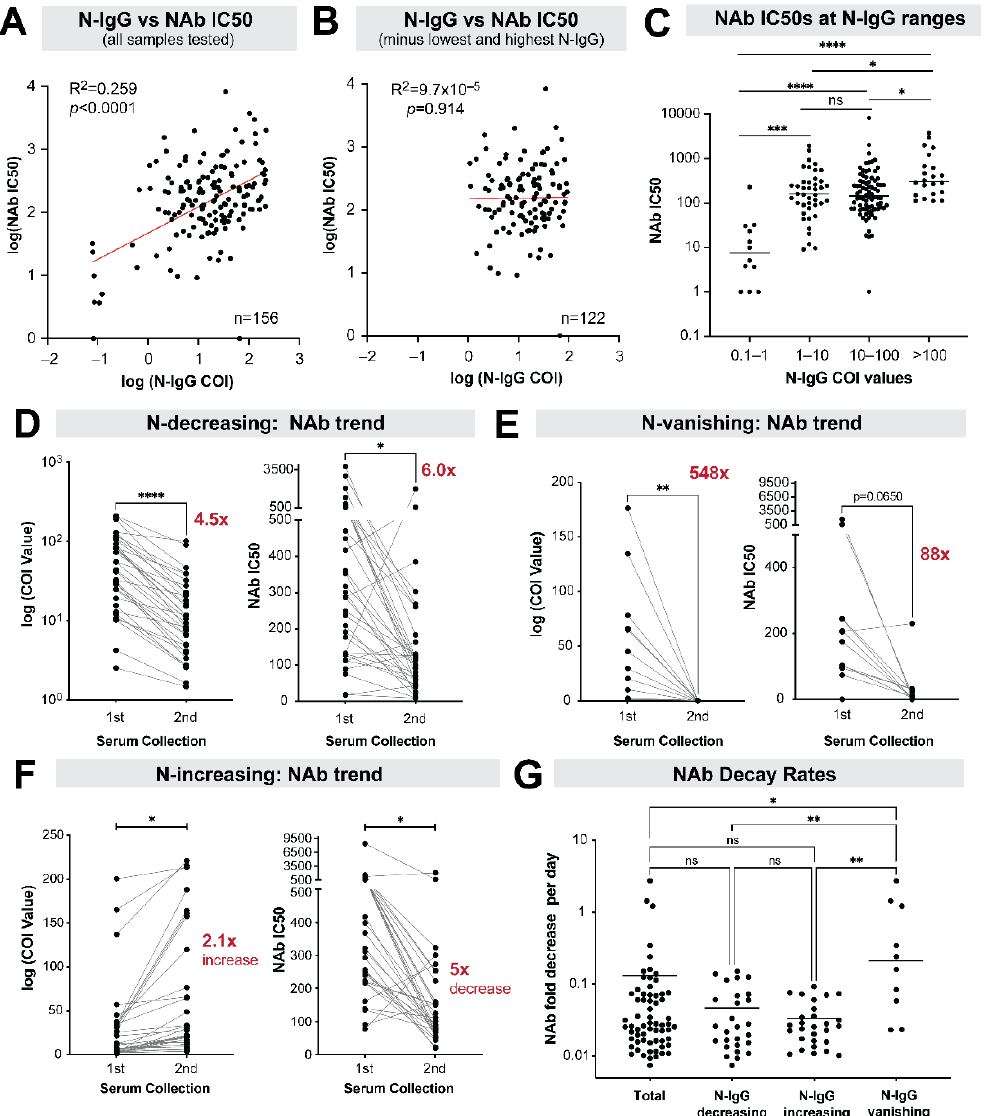
Figure 2. Assessment of neutralizing antibody responses among individuals with serum specimens. Collected at two time points and subjected to a lentivirus-based pseudovirion assay. ( A ) Correla- tions between NAb IC50s assessed against nucleocapsid IgG positive COI values using linear re- gression. ( B ) Serum specimens with COI values <1 and >100 removed. ( C ) Mean NAb IC50 values for 4 groups of nucleocapsid IgG COI values evaluated using ANOVA followed by Kruskal-Wallis test and grouped based on whether the nucleocapsid IgG positive COI values were ( D ) decreasing, ( E ) vanishing, or ( F ) increasing. Trends are highlighted in the graphs on the left of each panel. For each group, the NAb IC50 titers are assessed (right graphs on each panel) and differences evaluated using a 2- tailed paired Student’s t -test. ( G ) The fold-decrease in NAb divided by the time interval between serum collection compared between specimens with various nucleocapsid IgG reactivity trends using ANOVA and Kruskal-Wallis test. For all panels: * p < 0.05, ** p < 0.01, *** p < 0.001, **** p < 0.0001.